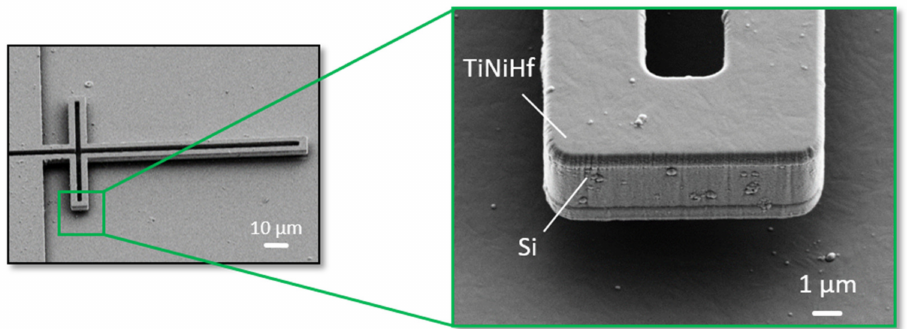
Figure 4. Scanning electron micrographs of a freestanding TiNiHf /Si microactuator with folded beam structure for temperature homogenization. The thicknesses of the TiNiHf film and Si layer are 440 nm and 2 µ m, respectively. Dimensions of cantilever beams: 75 µ m length ( l ), 3 µ m width ( w ) and 30 µ m length of folded beam structure ( l wing